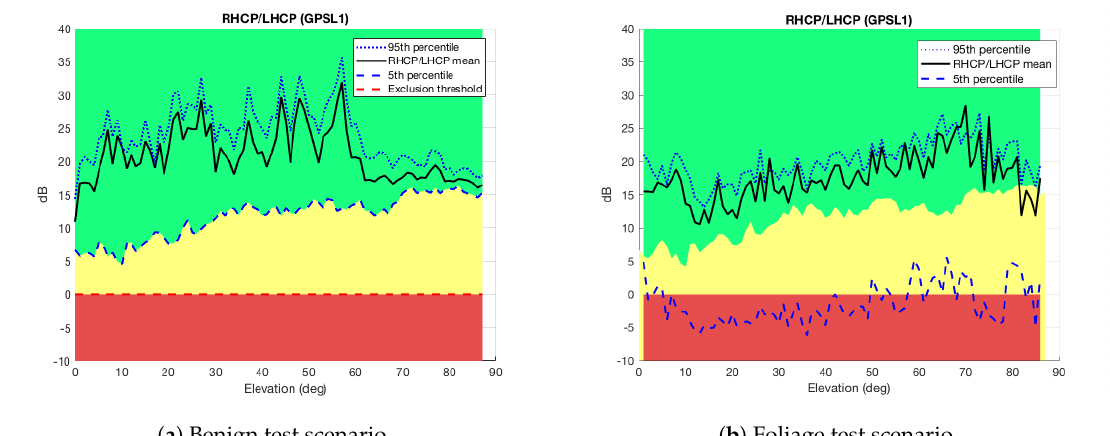
Figure 7. RLR components as a function of the elevation angle for the benign ( a ) and foliage ( b ) scenarios. Three different zones are defined: Severe multipath or NLOS (red), moderate multipath (yellow), and nominal conditions